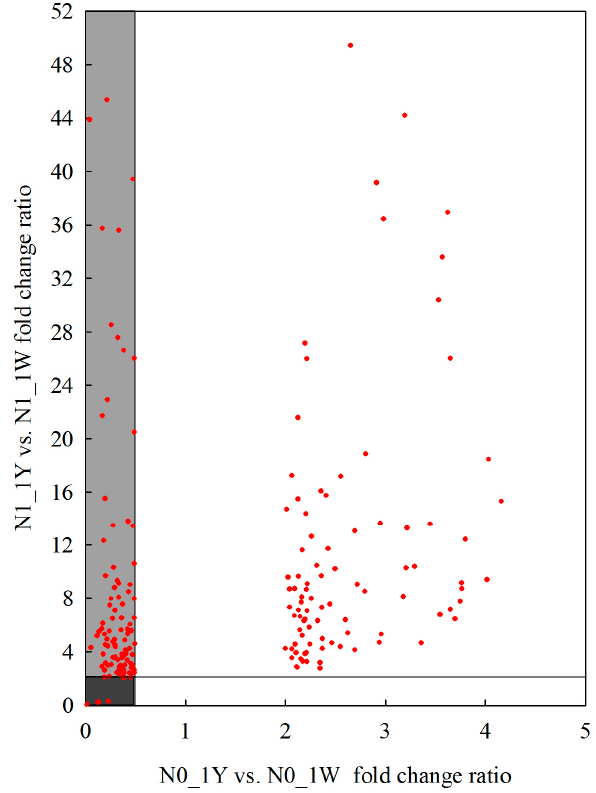
Figure 6. Scatter plot comparing the relative expression ratio for the 203 upregulated genes specifically expressed in the N0_1W vs. N1_1W comparison between wheat NILs under each N treatment. Each point represents an individual DEG, and the lighter section of the diagram shows the genes that are potentially frontloaded in expression.